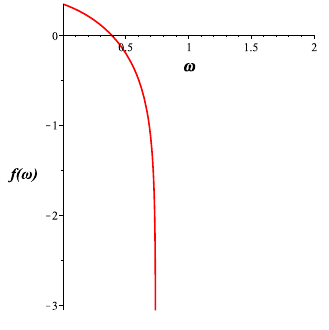
Figure 15. The complete solution u ( x,t ) for the Lorentz noise with the parameters given